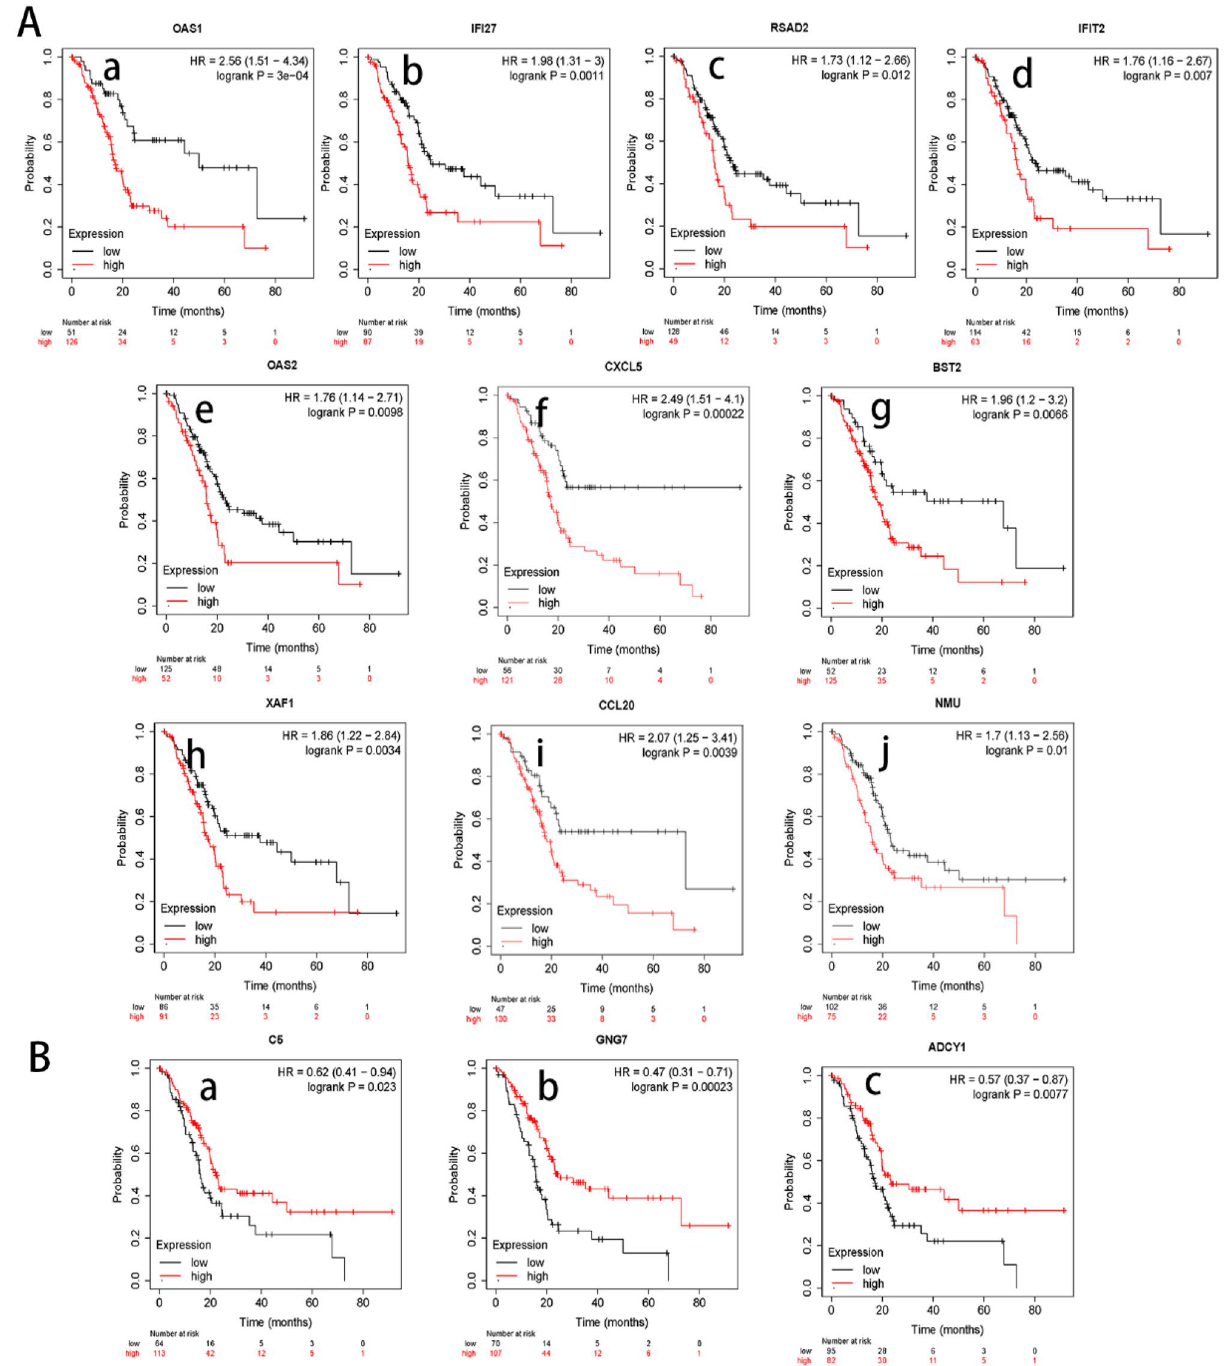
Figure 3. Overall survival of the genes with expression in accordance with that in Kaplan–Meier Plotter database (http:// kmplot. com/ analy sis/). ( A ) High expression of 10 up-regulated genes was associated with poor overall survival in PAAD (a-j). ( B ) Low expression of 3 down-regulated genes was associated with poor overall expression in PAAD was incrementally downregulated with increasing neoplasm histology grades as well as tumor stages (Fig. 6A–D). The low expression of GNG7 mRNA was related to the neoplasm histology grades ( P = 0.045) and survival ( P = 0.007) in PAAD patients. The low expression of ADCY1 mRNA was related to gender ( P = 0.035), neoplasm histology grades ( P = 0.008), and survival ( P = 0.036) (Table 2). The Multivariate Cox Regression analysis showed that the GNG7 (HR (95%CI): 2.106 (1.357–3.269); P = 0.010) and ADCY1 (HR (95%CI): 1.881 (1.221–2.898); P = 0.004) low expression, neoplasm histology grades 3/4 (HR (95%CI): 0.637 (0.408–0.995); P = 0.047), preop-